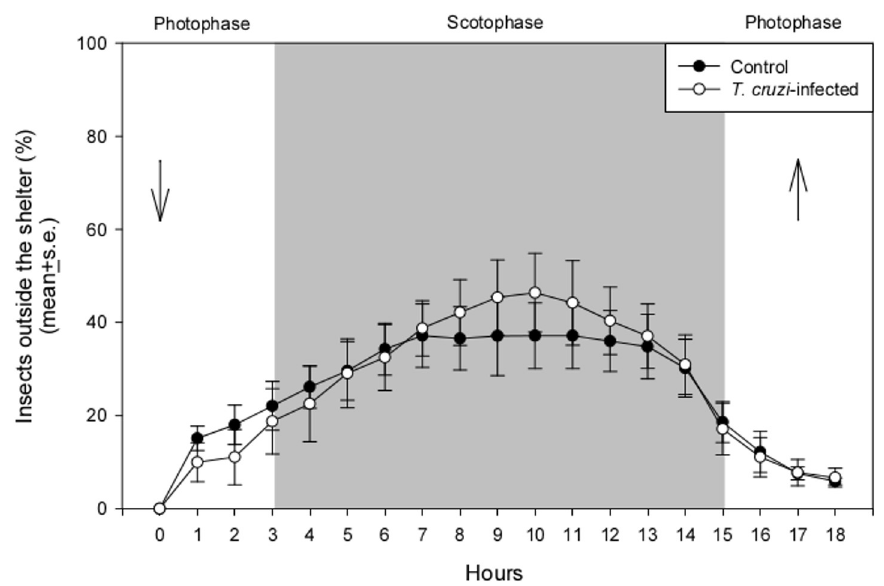
Fig 1. Percentage of Trypanosoma cruzi -infected and uninfected Rhodnius prolixus nymphs found outside shelters over time. Arrows represent host introduction and removal. Data depicted represent the mean ± s.e. of four independent